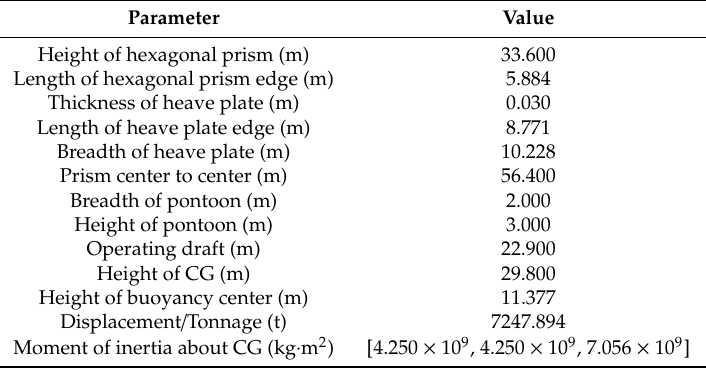
Table 2. Main Parameters of HexaSemi.